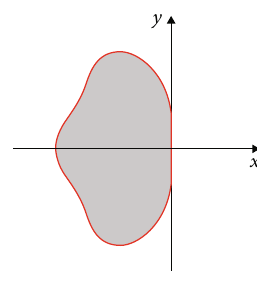
Figure 1: The stability region of the proposed method.